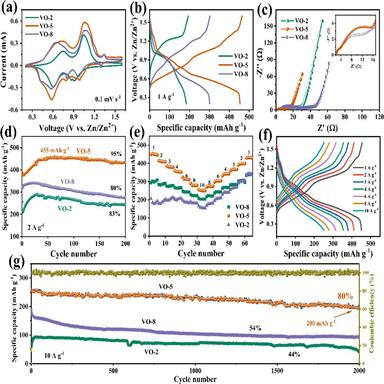
(a) CV curves recorded at 0.1 mV s − 1 . (b) GCD curves at 1 A g− 1 . (c) Nyquist plots of VO-2, VO-5, and VO-8. (d) Cycling performance of the three materials at 2 A g− 1 . (e) Rate capability tests of the samples at 1–10 A g− 1 . (f) Typical charge and discharge curves for the rate performance of VO-5. (g) Long cycle performance of VO-2, VO-5, and VO-8 at 10 A g− 1 .